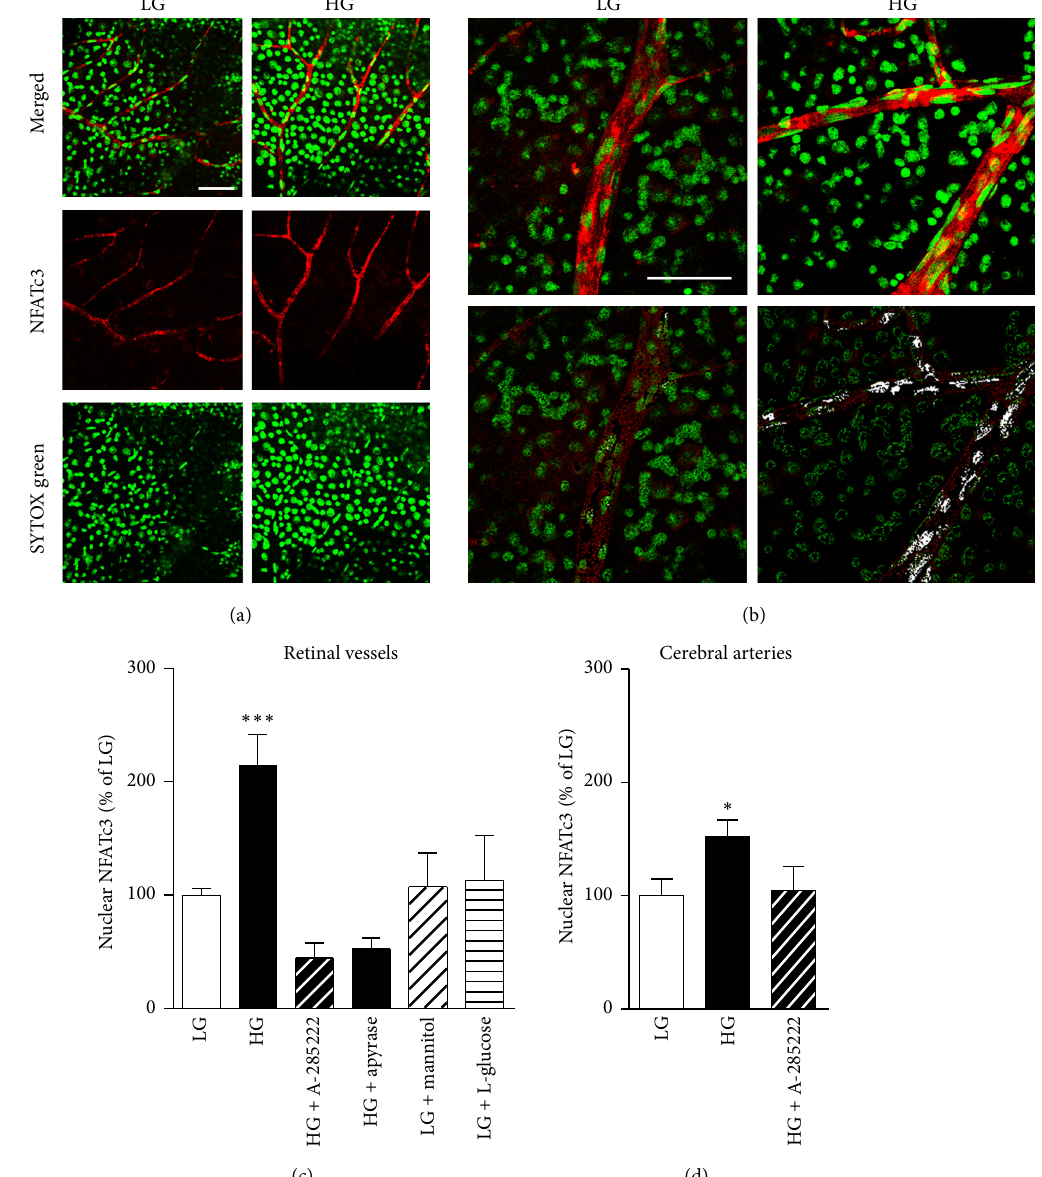
Figure 2: High glucose activates NFATc3 in the endothelium of retinal vessels. (a) Representative confocal immunofluorescence images of retinal whole-mounts, stimulated for 30 min in low (LG; 2 mmol/L; left panels) or high (HG; 20mmol/L; right panels) extracellular glucose and stained for NFATc3 (red) and SYTOX green for identification of nuclei (green). Merged and individual channel images are shown. Endothelial cells were identified by the orientation of their nuclei. (b) Higher magnification confocal images of retinal whole- mounts stimulated and stained as in ((a), upper panels) and pseudocolored images to visualize colocalization of NFATc3 and SYTOX green (white; lower panels). Scale bars = 50 𝜇 m. (c) Summarized mean fluorescence intensity data from experiments as in (a), showing NFATc3 nuclear accumulation after 30 min stimulation in LG or HG in the presence or absence of A-285222 (1 𝜇 mol), or apyrase (3.6 U/mL), or after stimulation with LG plus mannitol (18mmol/L), or LG plus L-glucose (18 mmol/L). 𝑁 = 21 and 22 retinas for LG and HG, respectively; 5–7 retinas for the other stimulatory conditions. ∗∗∗ 𝑃 < 0.001 versus all other groups. (d) Summarized mean fluorescence intensity data showing NFATc3 nuclear accumulation in mouse cerebral arteries after 30 min stimulation in LG or HG in the presence or absence of A-285222 (1 𝜇 mol). 𝑁 = 5 /group. ∗ 𝑃 < 0.05 versus